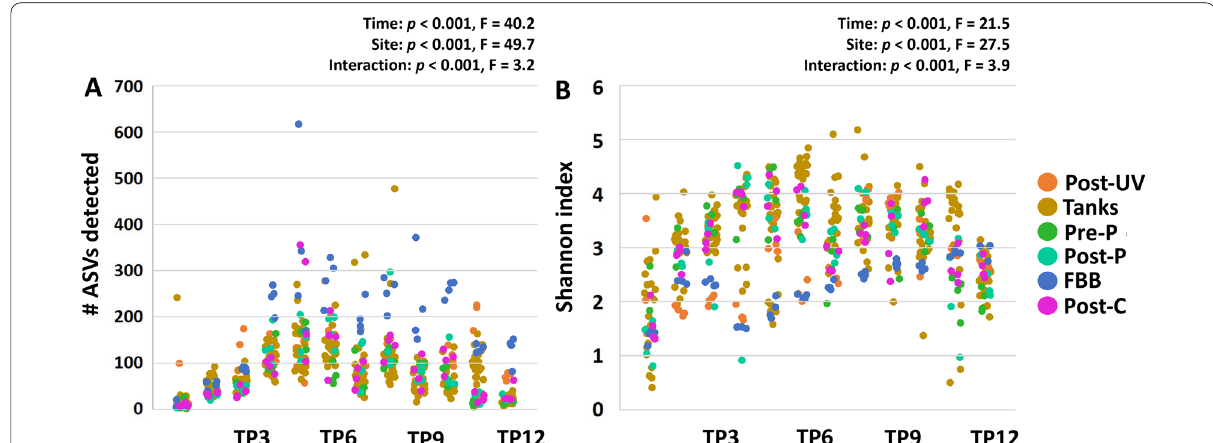
Fig. 2 Richness and diversity of the system microbiome plateaus by approximately four weeks post-population. Dot plots showing the detected richness ( A ) and Shannon diversity ( B ) at each sample site (legend at right), and at each time-point (TP) from TP1 through TP12. p and F values associated with main effects of time and sample site based on two-way analysis of variance